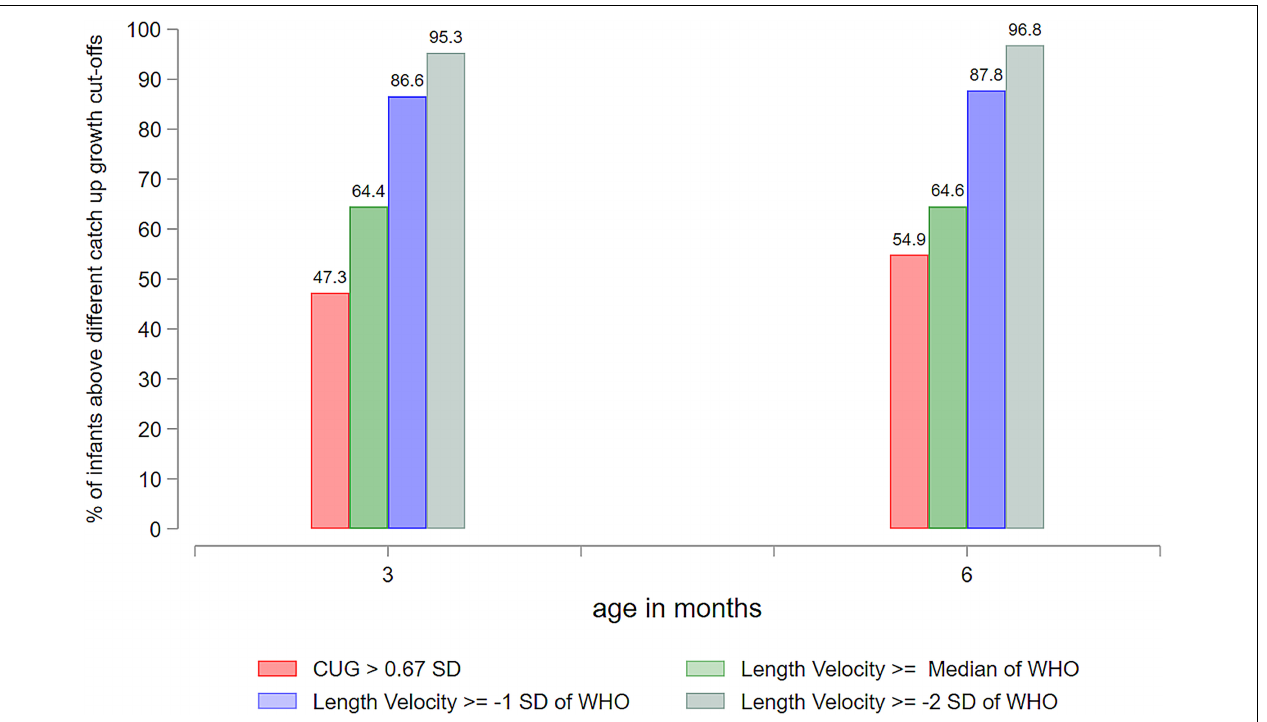
FIGURE 2 | Performance of low birthweight small-for-gestational-age (SGA-LBW) infants with respect to different growth cut-offs at 3 and 6 months of age.